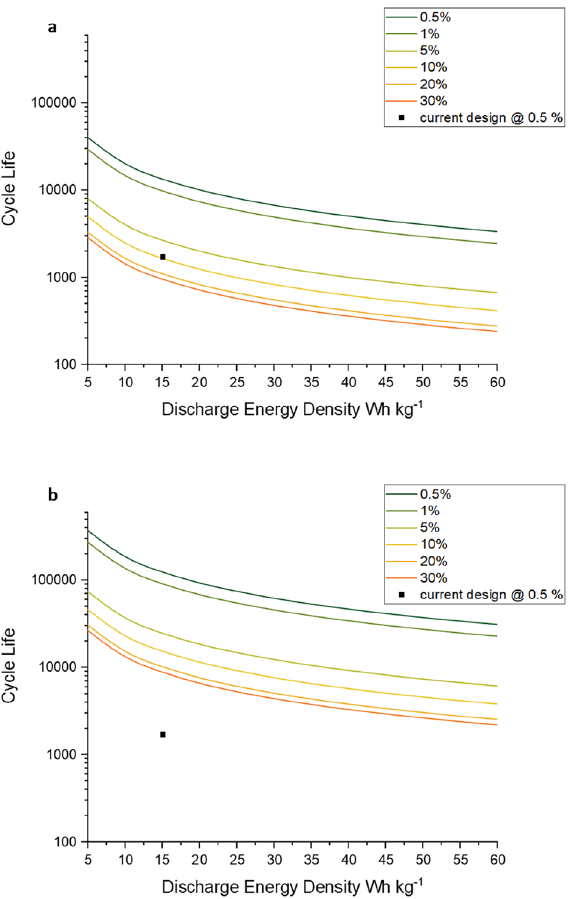
Figure 4. Competitive parameter space representing the functional energy density required to match Li-ion climate change impacts for a given % active material, compared to ( a ) (Siret 16 ) and ( b ) (Peters et al. 7